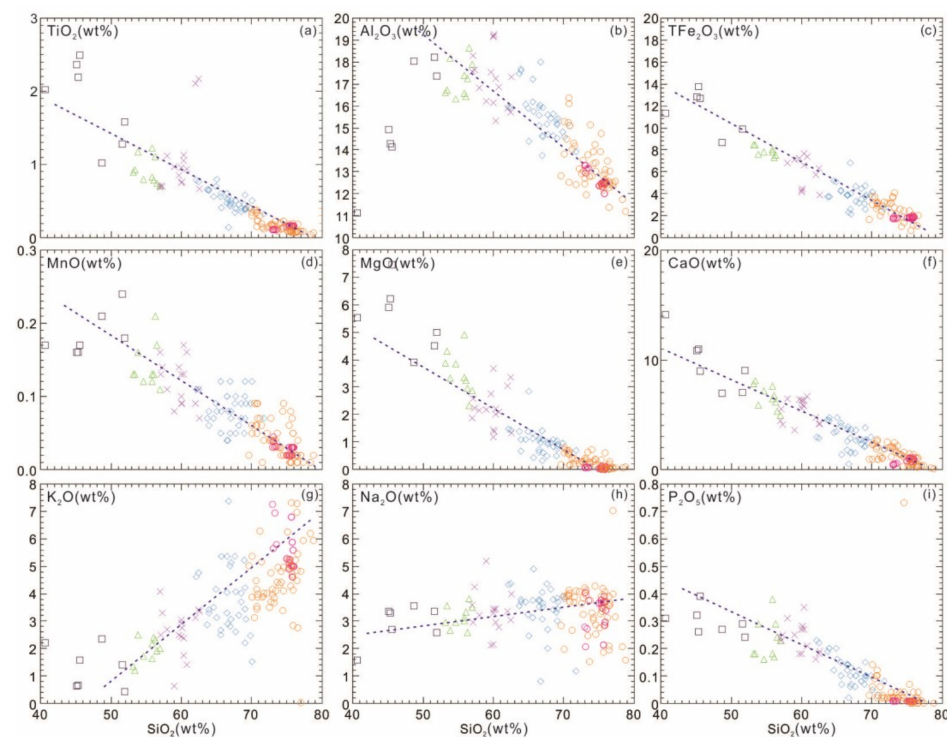
Figure 7. Harker diagrams of the Keri rhyolites in the EKOB. Dashed lines show linear trends, indicating the important role of magma mixing. ( a ) SiO 2 vs. TiO 2 diagram; ( b ) SiO 2 vs. Al 2 O 3 diagram; ( c ) SiO 2 vs. TFe 2 O 3 diagram; ( d ) SiO 2 vs. MnO diagram; ( e ) SiO 2 vs. MgO diagram; ( f ) SiO 2 vs. CaO diagram; ( g ) SiO 2 vs. K 2 O diagram; ( h ) SiO 2 vs. Na 2 O diagram; ( i ) SiO 2 vs. P 2 O 5 diagram.